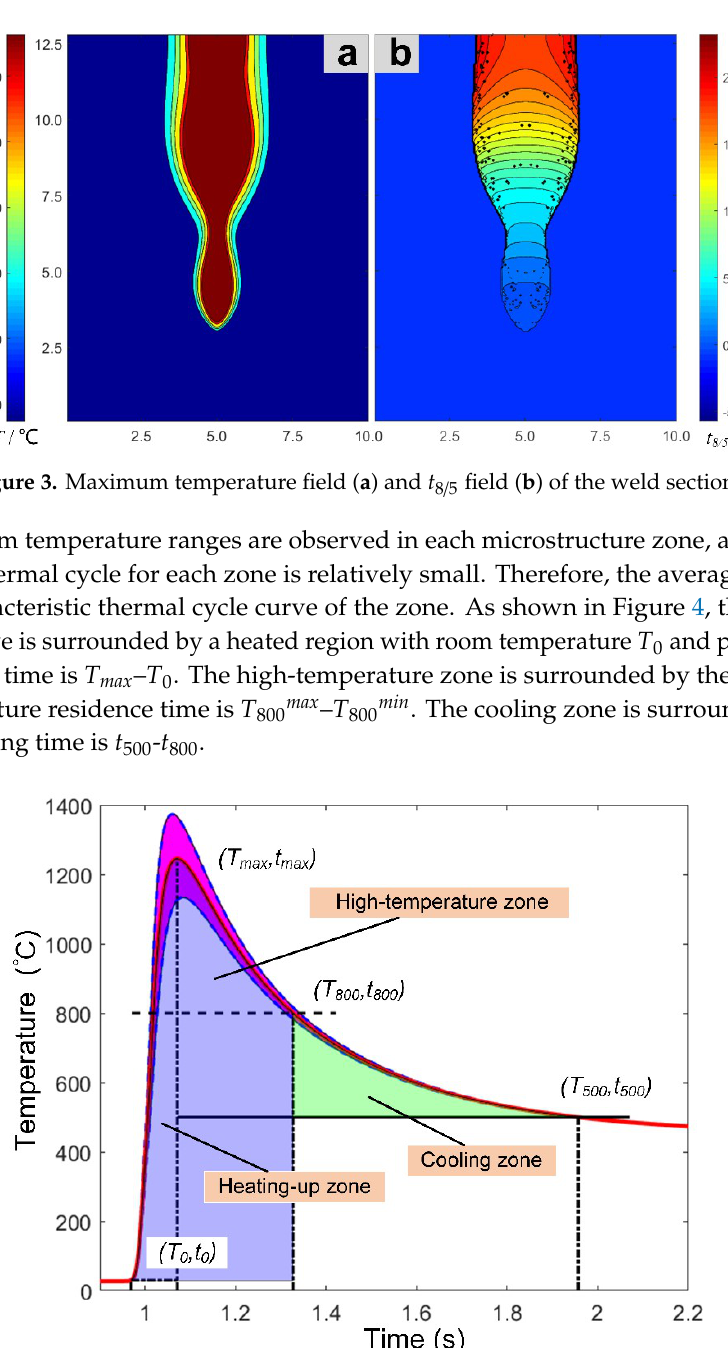
Figure 4. Thermal cycle curve and mean value curve of the laser-welding temperature field in the coarse-grained heat-affected zone.